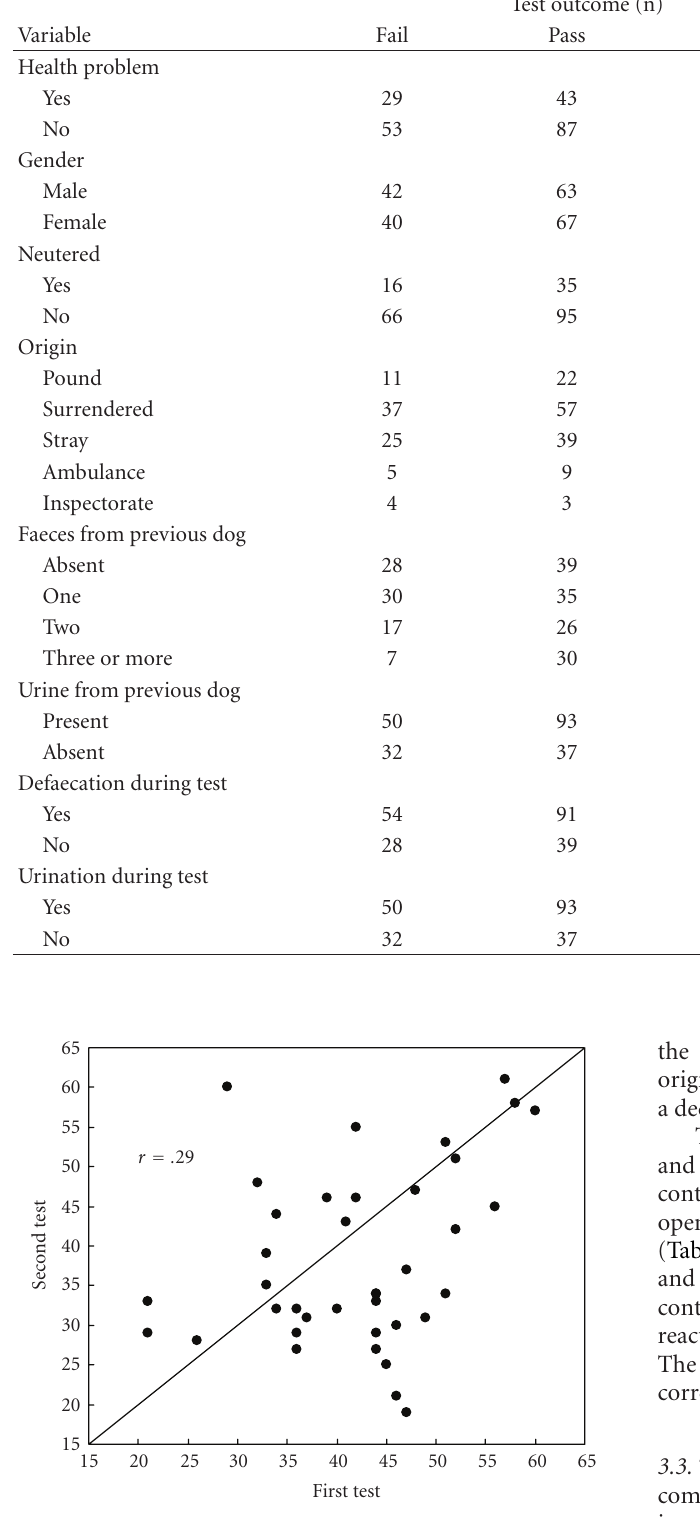
Figure 1: The relationship between the first and second test scores, with 1: 1 line